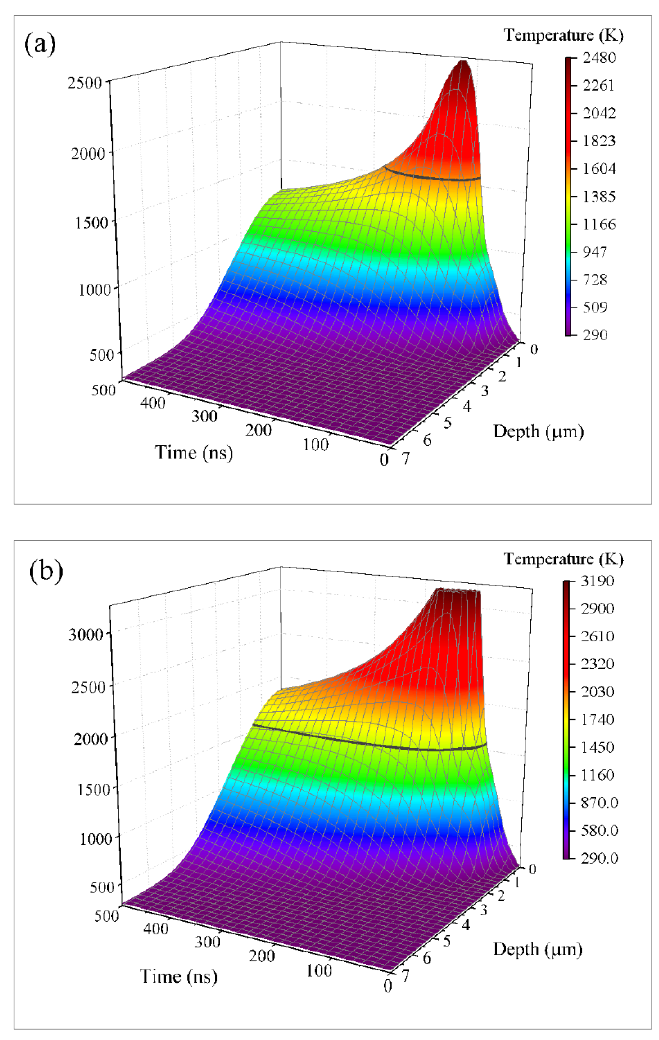
Figure 5. Temperature field distribution in IN718 by IPIB with current density ( a ) 100 A/cm 2 and ( b ) 200 A/cm 2 .